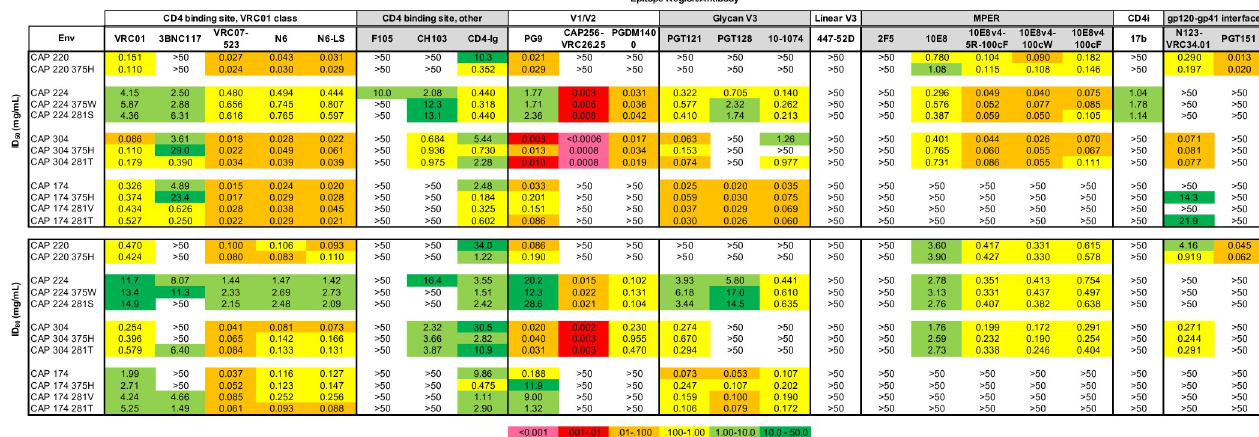
Fig 6. Neutralization sensitivity of HIV Env and SHIVs with 281/375 mutations. Neutralization sensitivity is reported as the concentration ( μ g/mL) at which relative luminescence units were reduced 50% (ID 50 ) or 80% (ID 80 ) compared to virus control wells.